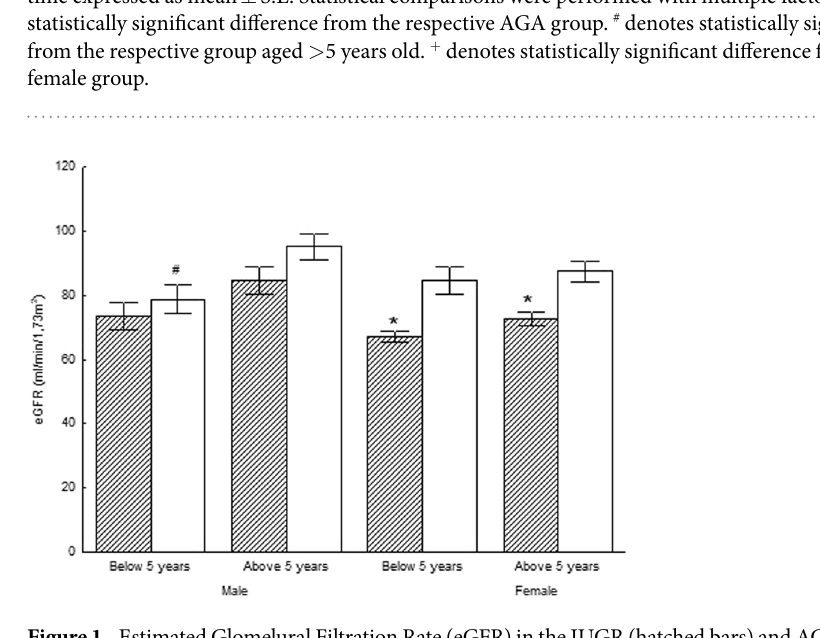
mean AST z-score was significantly higher in those born with IUGR than in those born AGA (p < 0.05). The mean ALT z-score was significantly higher in male subjects born with IUGR and aged < 5 years old than in their respective control AGA subjects (p < 0.05). Mean ALT z-score was significantly higher in male subjects born with IUGR than in female subjects born with IUGR (p < 0.05). Mean total cholesterol, HDL-c and LDL-c z-scores were not significantly different among the studied groups (p < 0.05). In all female subjects mean TG z-score was significantly higher in those born with IUGR than in those born AGA (p < 0.05), while it was significantly higher in female subjects born with IUGR and aged < 5 years old than in their respective control AGA subjects (p < 0.05). Mean TG z-score was significantly lower in male subjects born with IUGR and aged < 5 years old than in their respective female subjects born with IUGR (p < 0.05).